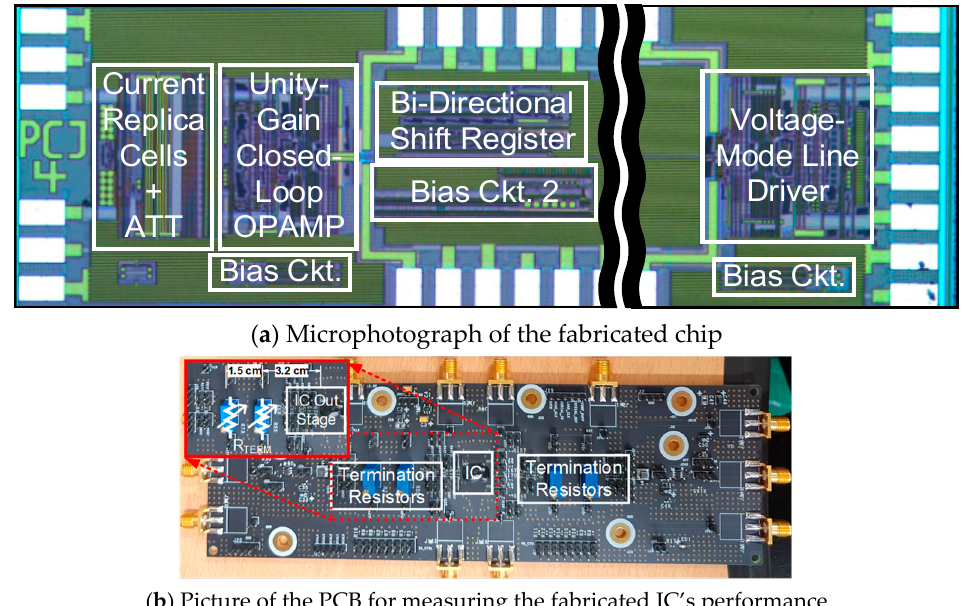
Figure 10. Microphotograph and test board of the fabricated chip.